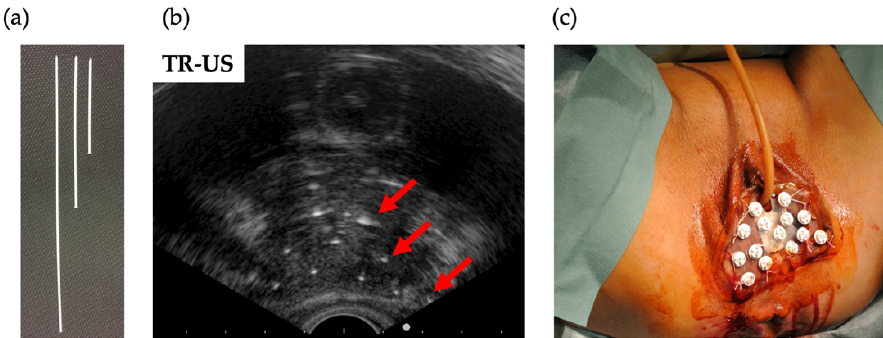
Figure 2. Transrectal ultrasound-guided perineum interstitial needle insertion. ( a ) One-end plastic interstitial catheter. ( b ) Red arrows indicate plastic catheters placed 1.5–2.0 cm apart. ( c ) the perineum after insertion.